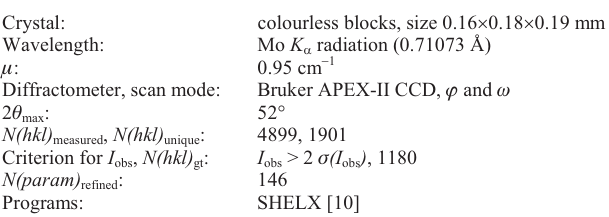
Table 1. Data collection and handling.